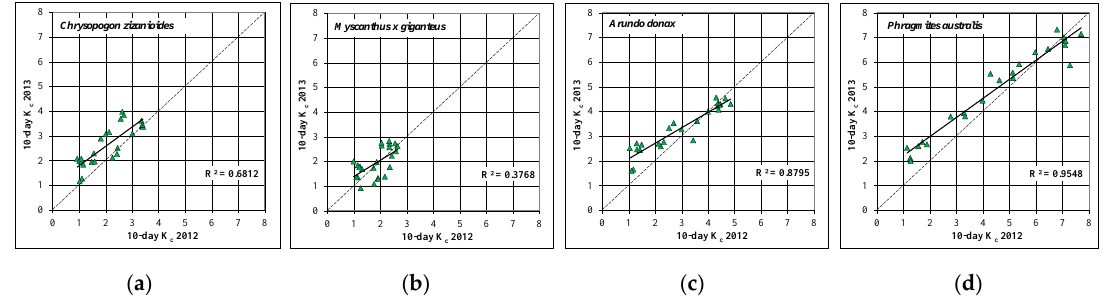
Figure 10. Relationship between 10-day crop coefficient (K c ) for C. zizanioides ( a ), M. giganteus ( b ), A. donax ( c ), and P. australis ( d ) in 2012 and 2013 observation periods.